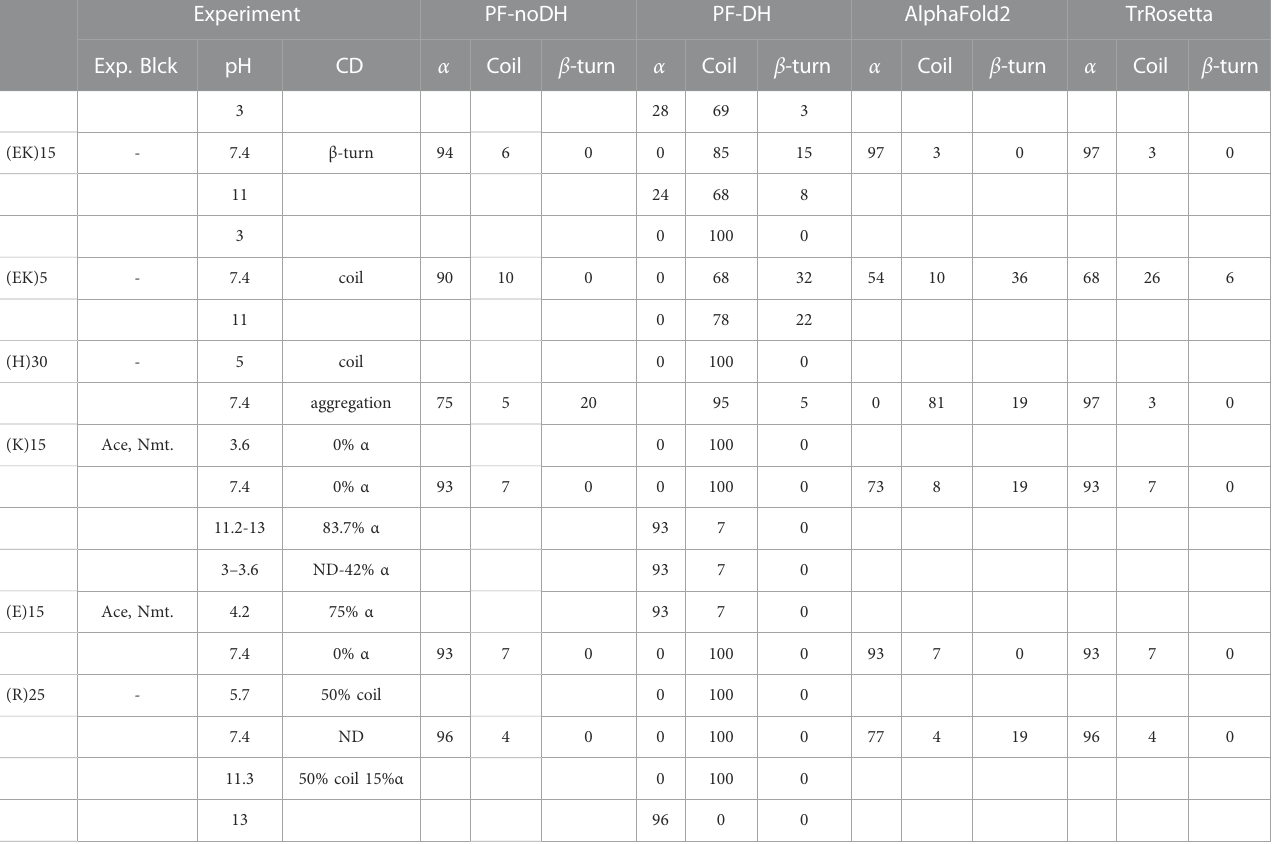
TABLE 1 Structural impact of pH variation on poly-charged